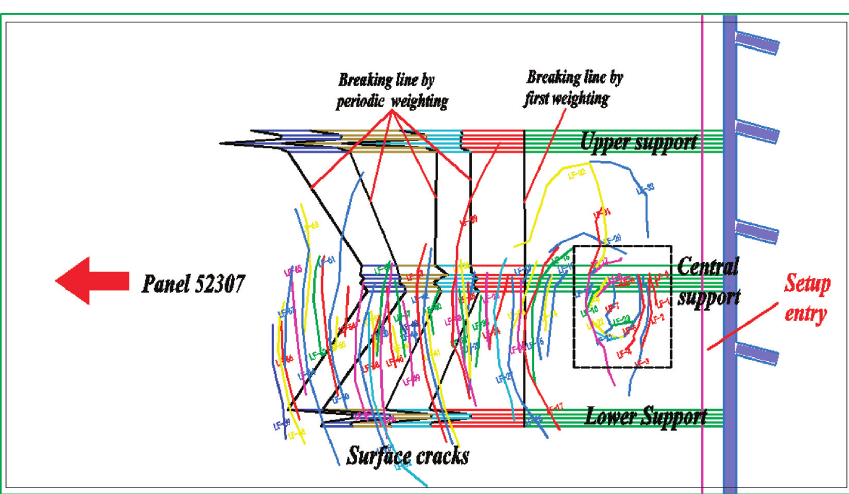
Figure 6: Spatial-temporal relationship between weighted breakage distance and surface